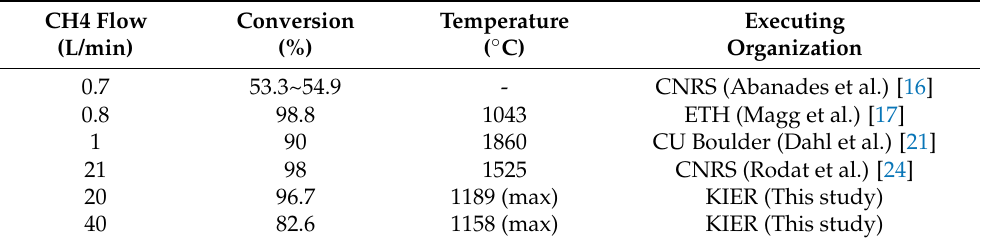
Table 3. Thermal amounts at the reactor surface according to the focal